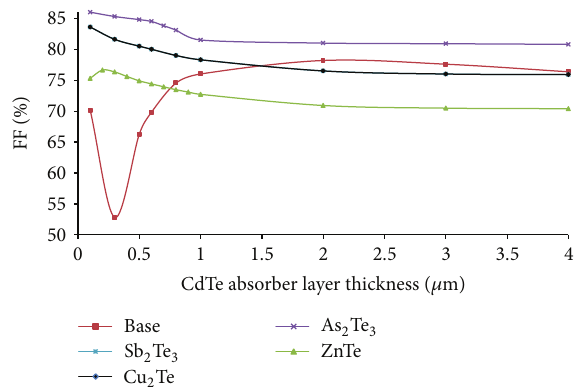
Figure 5: Effect of different BSF on cell fill factor on proposed cell with variable absorber thickness.